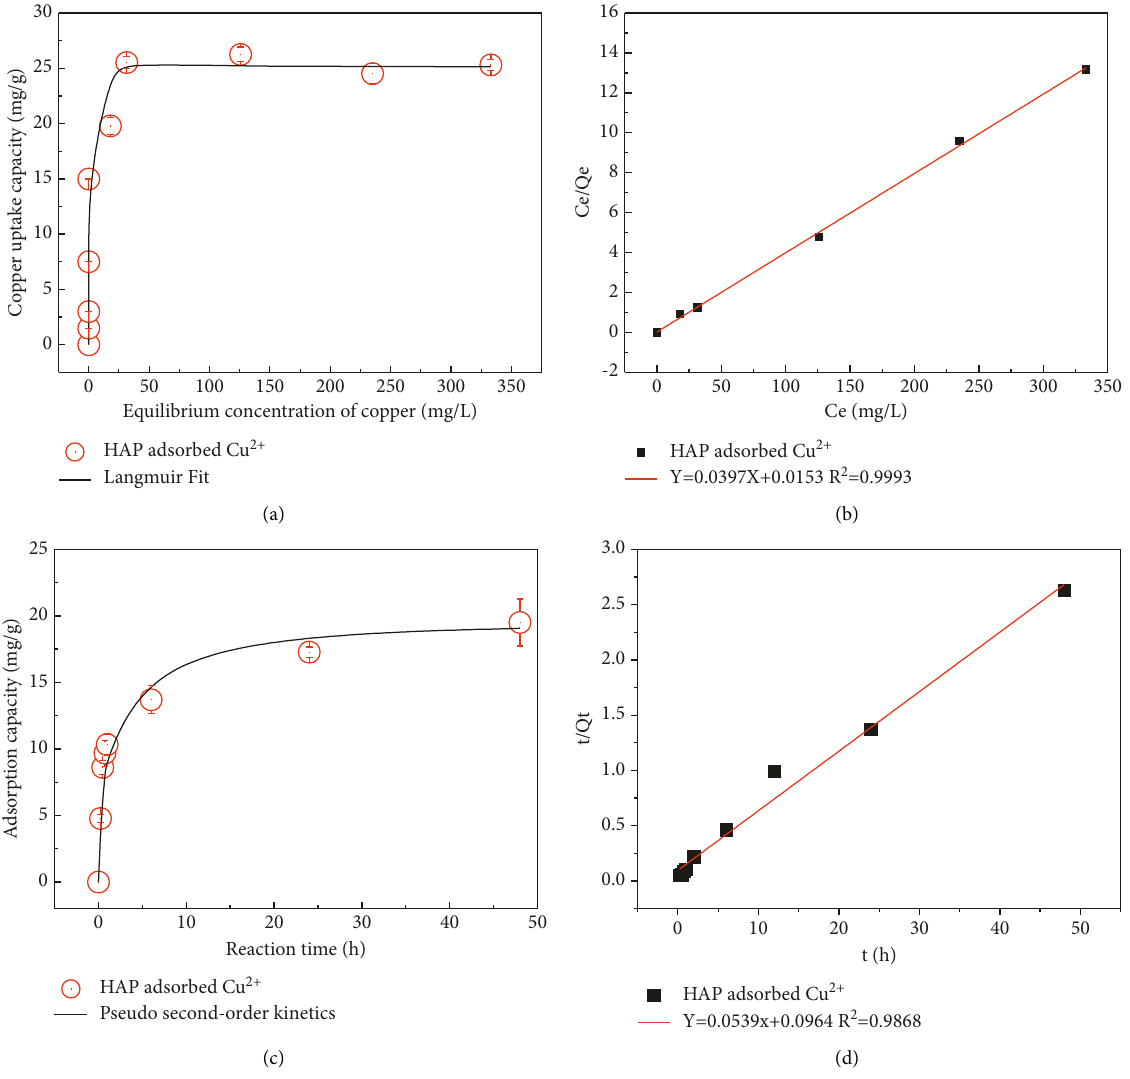
Figure 2: (a) Adsorption equilibrium isotherm of copper on hydroxyapatite. Langmuir model fitting. (b) Linear plot of Langmuir model for adsorption isotherm. (c) Adsorption kinetic of copper on hydroxyapatite. Pseudo-second-order kinetic model fitting (adsorbent dosage: 0.2g; copper concentration: 500mg/L; solid/solution ratio: 6.7g/L at 25 ± 2 ° C). (d) Linear plot of pseudo-second-order kinetic model for adsorption kinetics. Table 1: Adsorption capacity of copper by various